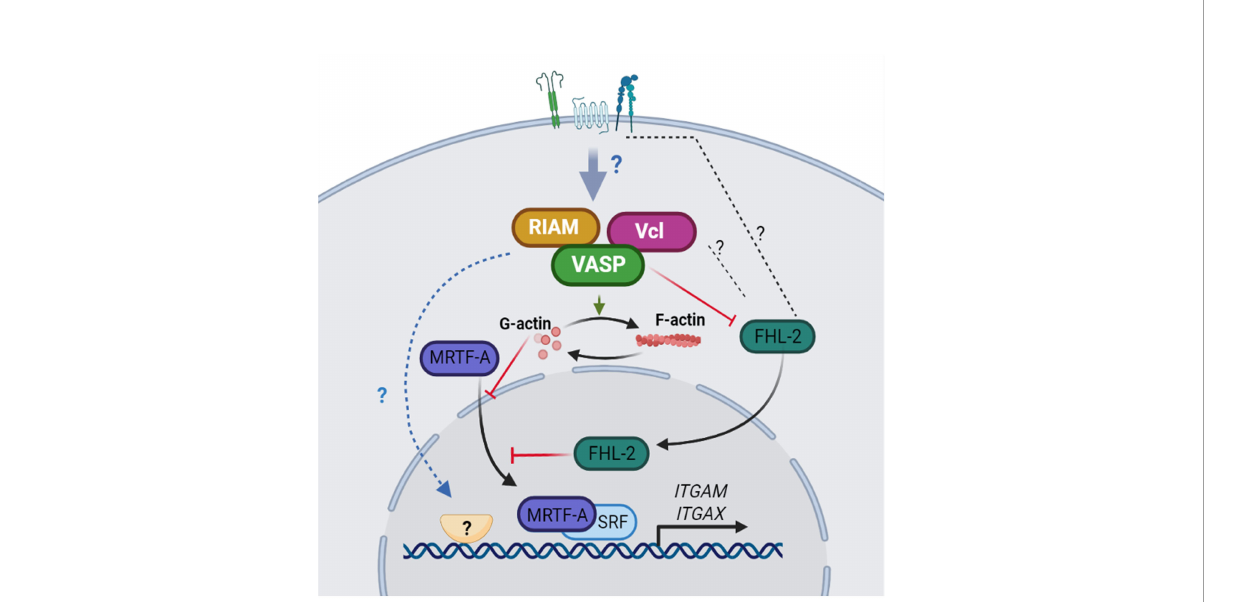
FIGURE 8 A model for integrin a M and a X upregulation dependent on RIAM, VASP and Vinculin expression. The expression of RIAM, VASP and Vinculin downstream of receptor signaling, contributes to increase the polymerization of actin. The reduced G-actin content allows MRTF-A translocation to the nucleus where, in combination with the SRF transcription factor promotes a M expression predominantly. Simultaneously, FHL-2 is sequestered in the plasma membrane, possibly by interacting with integrins or associated components, reducing FHL-2 co-repressor activity on SRF and allowing integrin expression. In addition, RIAM, VASP and Vinculin could regulate the activity of other potential transcription factors involved in the control a M and a X